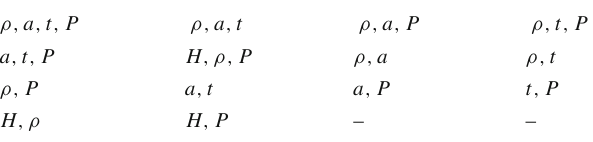
Table1 Thepossiblecombinationsofvariablesinvolvedinasymmetry transformation of the Einstein–Friedmann